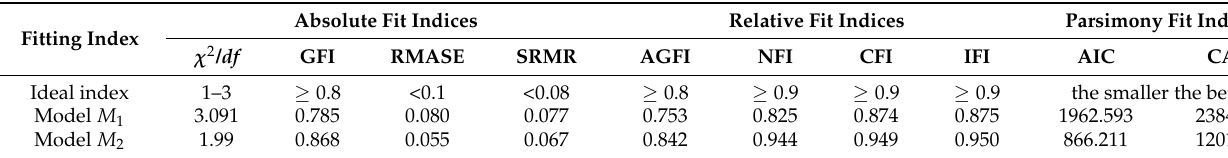
Table 5. Fitting indicators of model M 1 and M 2 .